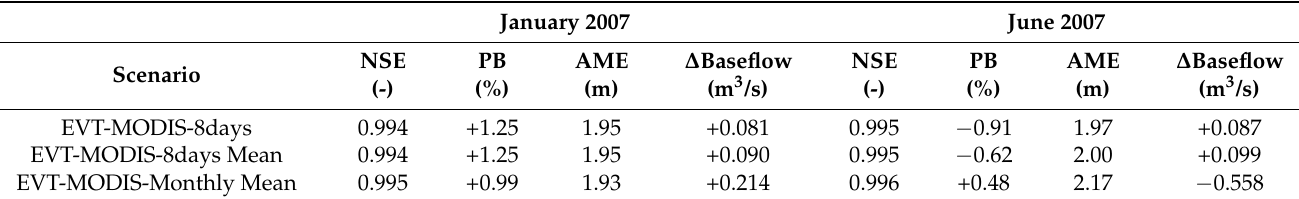
Table 4. Model performance indicators (Nash–Sutcliffe model efficiency coefficient, (NSE), percentage of bias (PB), and absolute mean error AME), and difference between observed and modelled baseflow for the different scenarios using distributed and mean evapotranspiration